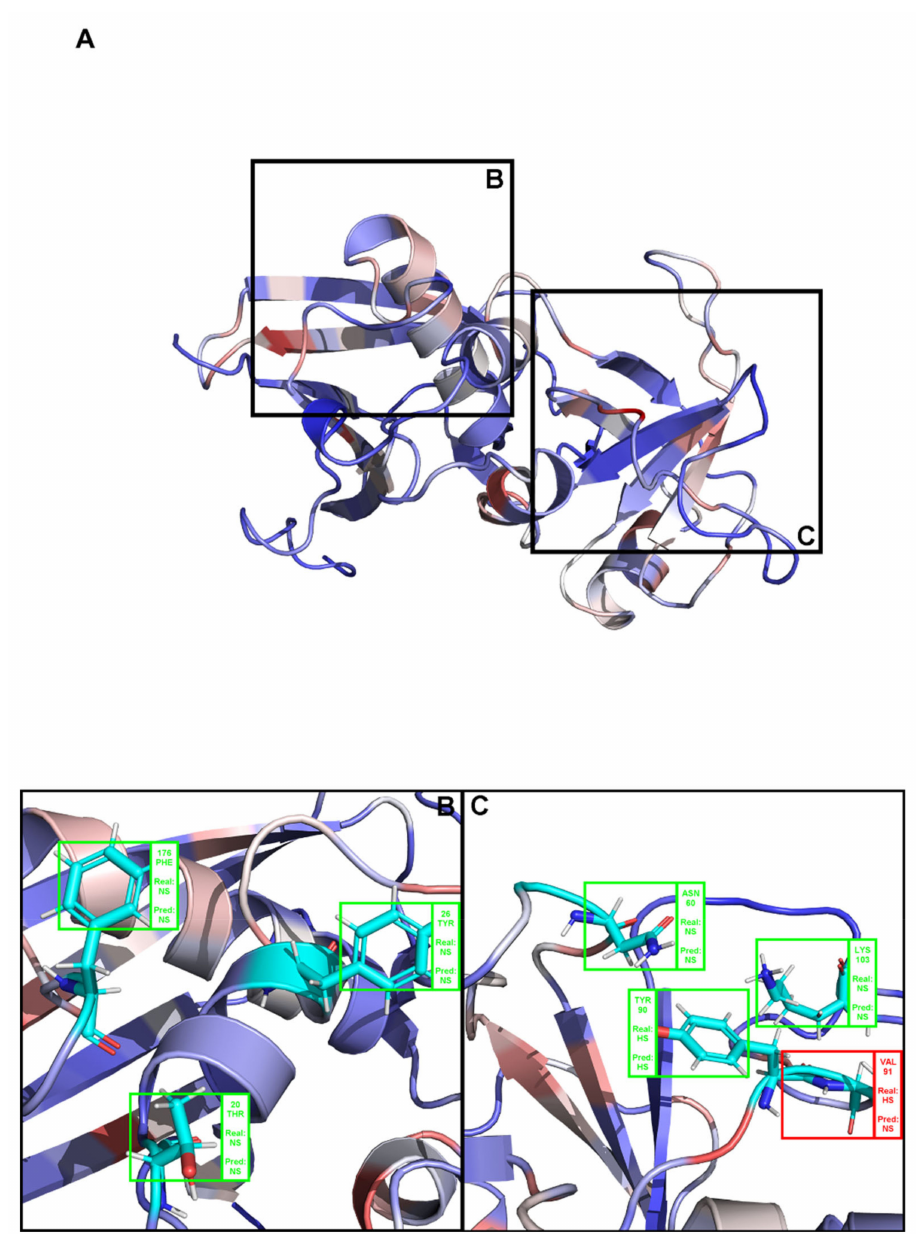
Figure A2. ( A ). Depiction the complex between a T-Cell receptor beta chain and SEC3 superantigen: PDB ID 1jck. Brighter red colors were attributed to residues with a higher probability of being classified as HS. ( B,C ) Close-ins of all interfacial residues for which there is an experimental ∆∆ G binding value, and as such a HS / NS classification. Green boxes represent correctly predicted residues, whereas red boxes represent incorrectly classified